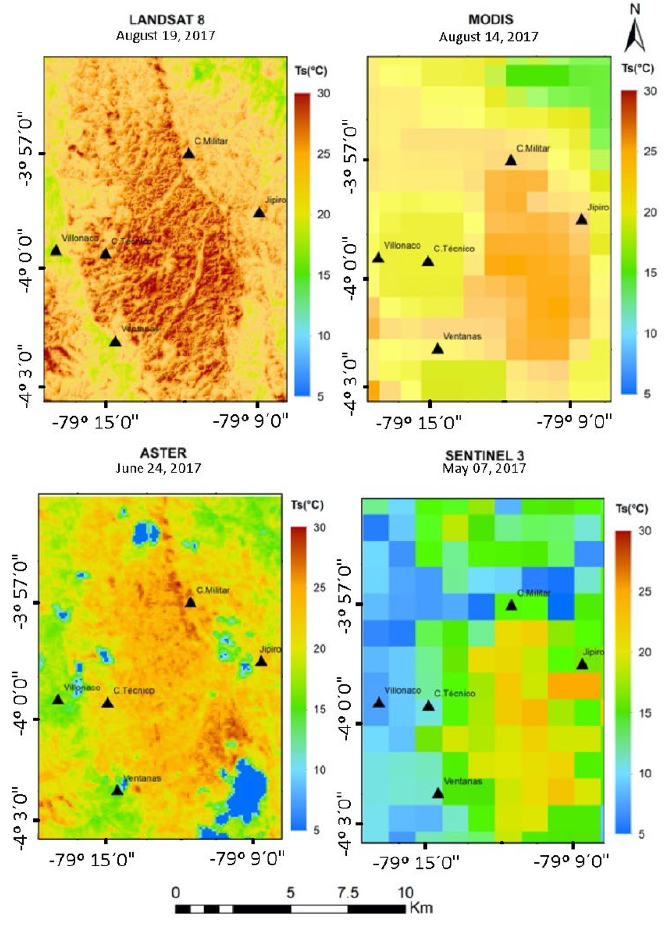
◦ C) for the different satellite products. Figure 2. Surface temperature (°C) for the different satellite products. Figure 2. Surface temperature ( Similar behavior was observed in the air temperature maps presented in Figure 3, where the distribution of Ta is more uniform. Additionally, the inverse proportionality between the elevation and Ta can be